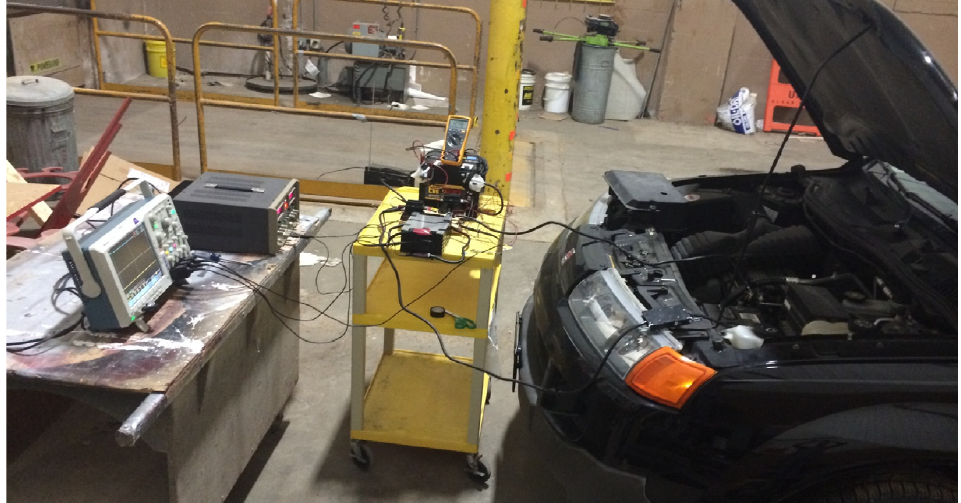
Figure 5. Engine cranking test setup on a Saturn Vue 2004.